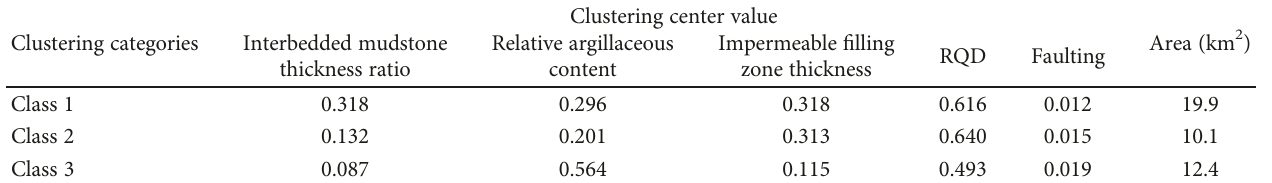
Figure 8: The water-resisting property classi fi cation of the fi lling zone on the top of Ordovician limestone. Table 3: The clustering results of